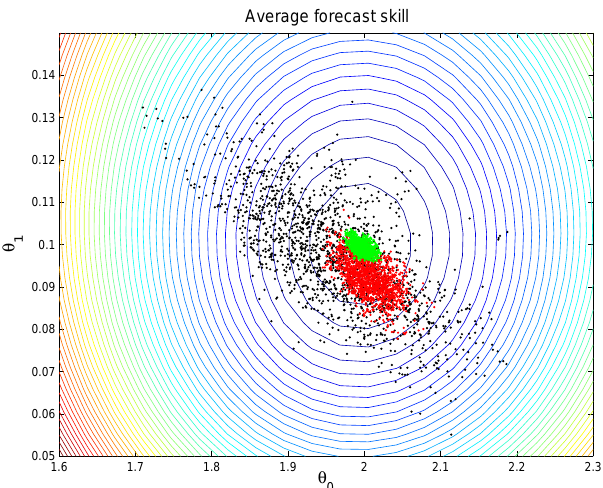
Fig. 8. Gaussian posterior approximations with 10, 5 and 2 times too small and too large σ 2